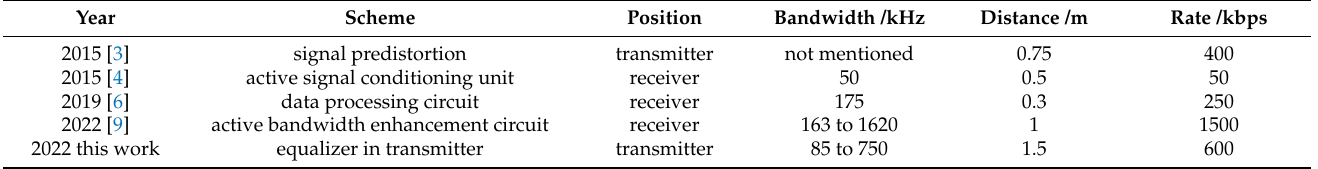
Table 1. Comparison of bandwidth-expanding schemes of the VLC system with solar